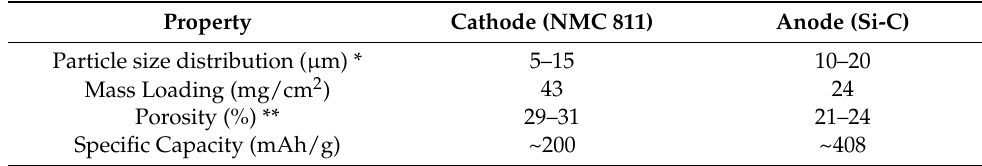
Table 2. Commercial cell electrodes properties.